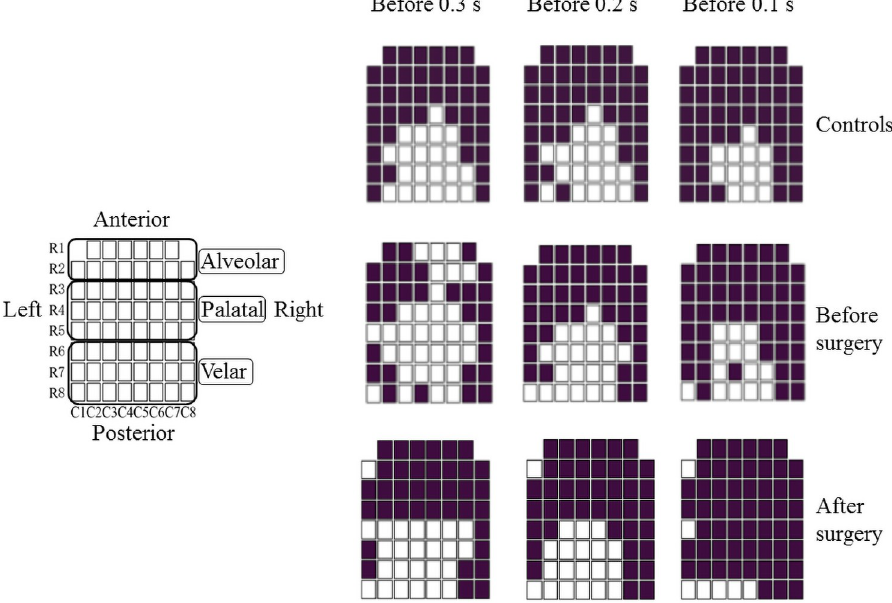
Fig 2. Plate classification. A schematic diagram of electrodes which were segmented by 8 horizontal rows (R1-R8) and vertical columns (C1-C8) across the palate. An EPG plate was divided into 3 parts of mesiodistal direction for detailed analysis (Alveolar, Palatal and Velar). Representative EPG pattern during swallowing in the controls, patients before surgery, and after surgery at 0.3, 0.2 and 0.1 seconds before complete tongue-palatal